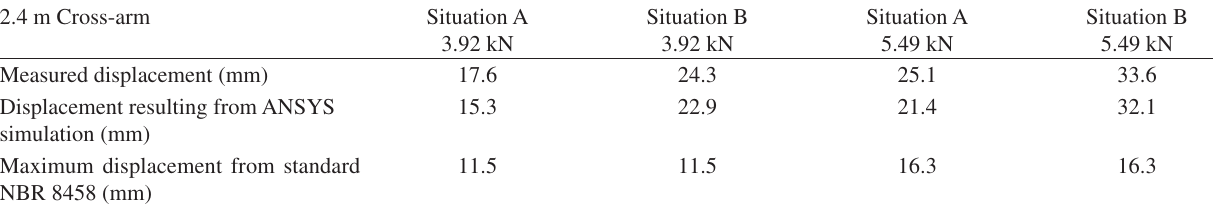
Table 3. Bending test results and simulations for Pinus elliottii.